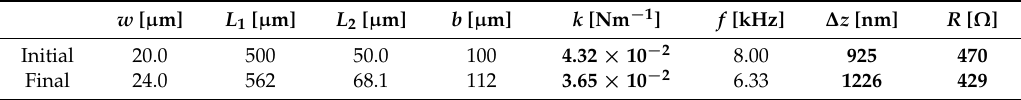
Table 4. Tri-objective optimization Opt3